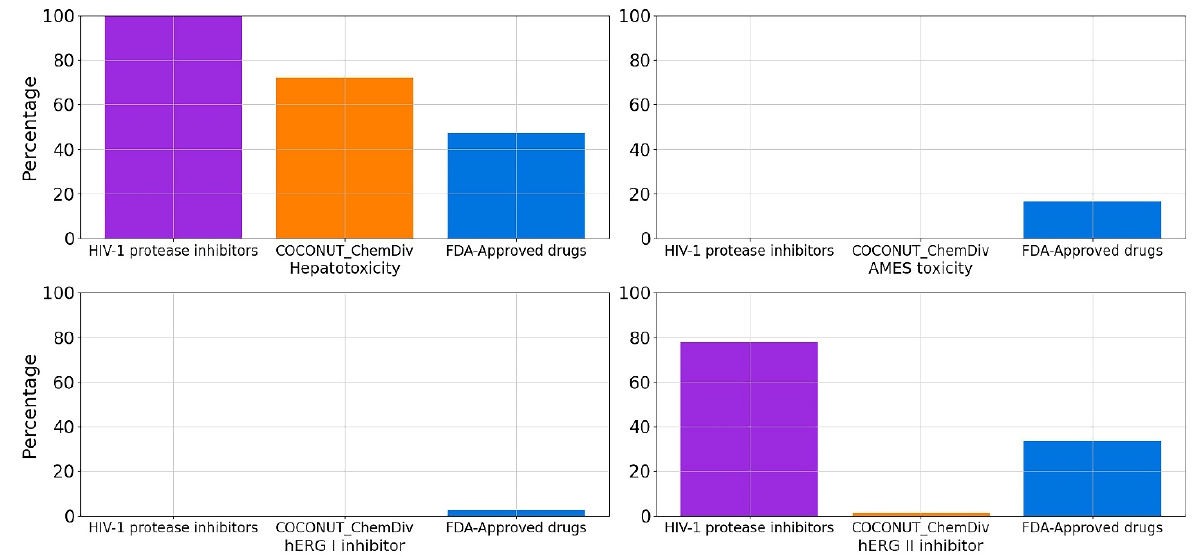
Figure 15. Percentage of compounds that are hERG I inhibitor, hERG II inhibitor, hepatotoxicity, and toxicity in AMES test in silico. Colors represent compounds: new chemical compounds generated from COCONUT fragments and ChemDiv fragments with physicochemical properties like FDA-approved HIV-1 protease inhibitors and easily synthetically accessible (orange), FDA-approved drugs (blue), FDA-approved HIV-1 protease inhibitors (purple).